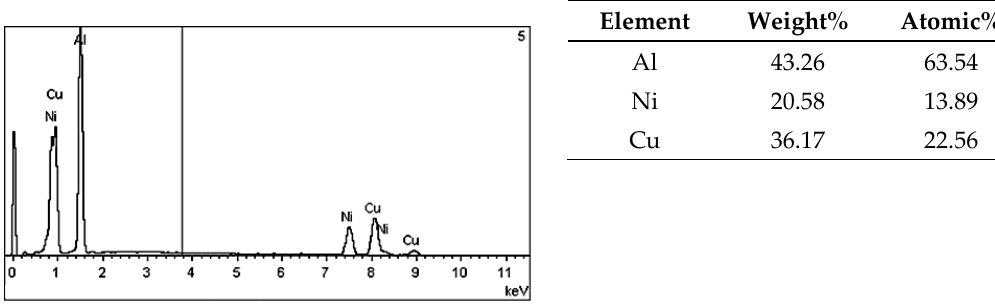
Figure 10. EDS diagram and chemical composition at point no. 5 of Figure 5.